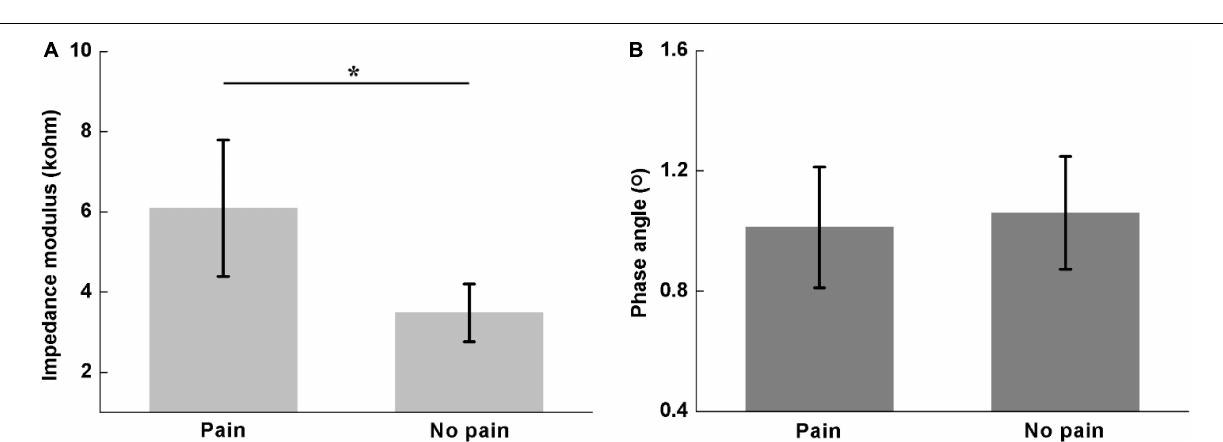
FIGURE 3 | Variability of impedance measurement at all measurement positions. (A) Coefficient of variation for the impedance modulus. (B) R coefficient of variation for the impedance phase angle.